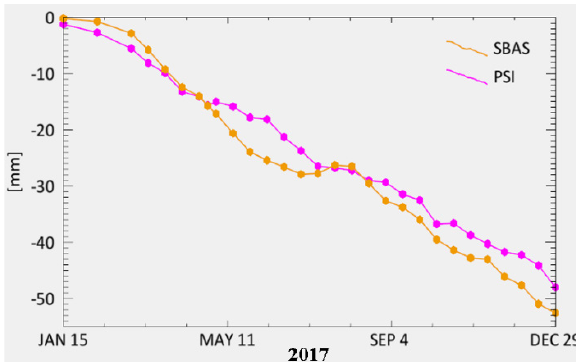
Figure 5. Displacement sequence of point ID 5168.